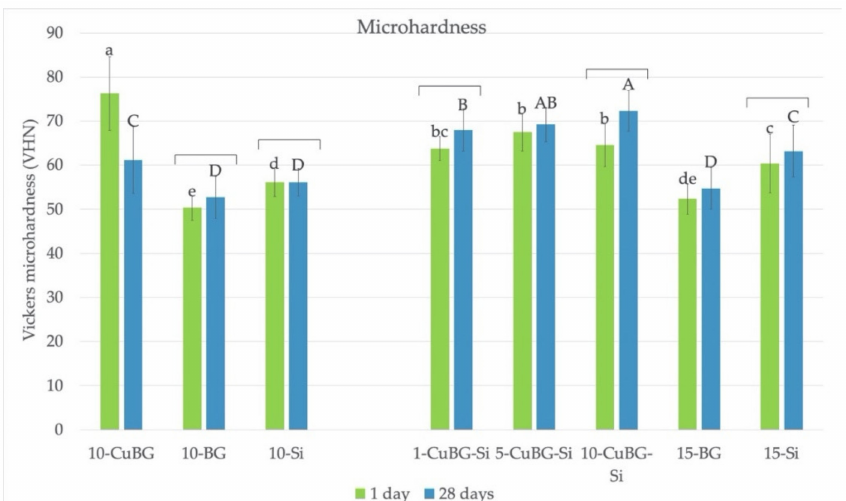
Figure 5. Vickers microhardness (VHN) of the tested materials after 1 and 28 days of exposure to saline solution measured at the top of the specimen. Lower case letters indicate no statistically signif- icant differences between groups after 1 day. Upper case letters indicate no statistically significant differences between groups after 28 days. Brackets indicate no statistically significant difference within the same material between 1 and 28 days.